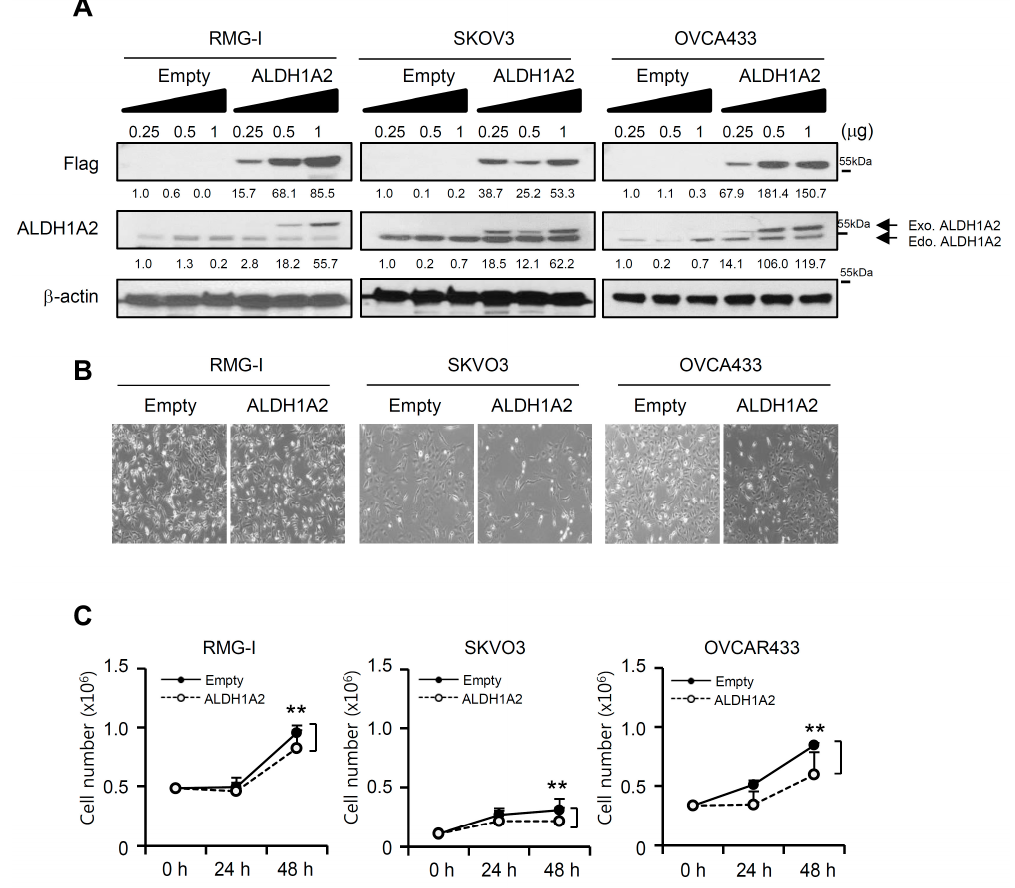
Figure 4. E ff ects of forced expression of ALDH1A2 on the proliferation of ovarian cancer cells. ( A ) Cells were transfected with vector expressing Flag-tagged ALDH1A2 or empty vector. After 24 h, whole lysates were immunoblotted with anti-ALDH1A2 and anti-Flag antibodies. β -Actin was used as a loading control. Densitometric analysis was performed by ImageJ software. The protein levels were normalized to the signal of β -actin. ( B , C ) E ff ects of forced expression of ALDH1A2 on the proliferation of ovarian cancer cell lines. Cells were transfected with Flag-tagged ALDH1A2 or empty vector. After indicated times, phase contrast images were observed ( B ). The cells were trypsinized with trypsin–EDTA, and the number of viable cells ( C ) was determined by a Vi-Cell XR cell viability analyzer at indicated time points. Original magnification: 20 × . Statistical significance was assessed using an unpaired t ‐ test. ** p < 0.05.